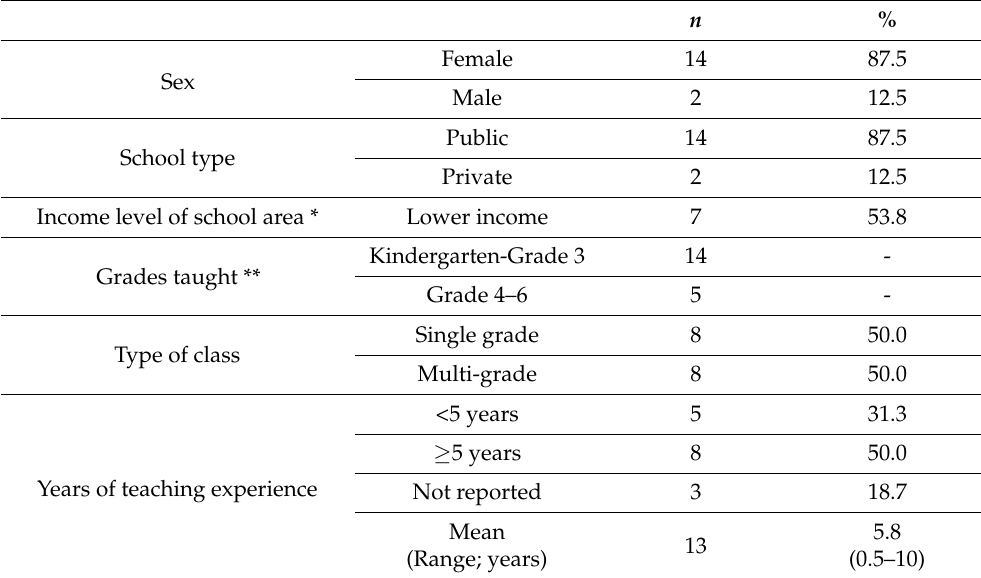
Table 1. Participant and interview characteristics (N =